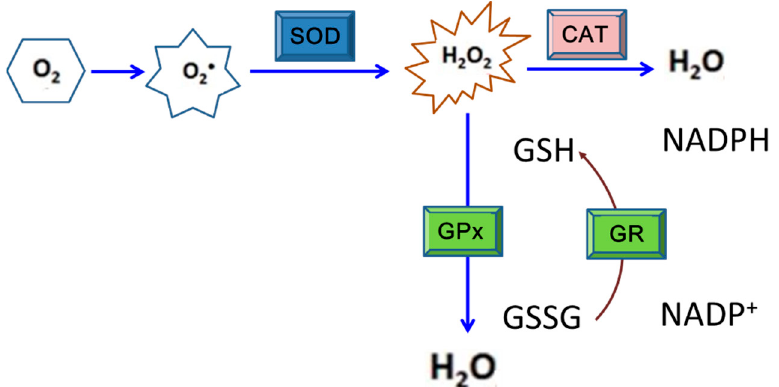
Figure 2. The enzymatic antioxidant system consisting of superoxide dismutase (SOD), catalase (CAT), glutathione peroxidase (GPx), and glutathione reductase (GR) that works for cell protection under oxidative stress. This is the principal defense system against reactive oxygen species (ROS) exposure in most organisms. SOD is able to catalyze the reaction to decompose superoxide anion radicals to H 2 O 2 , which is then converted to water and oxygen by CAT or GPx. Generally, CAT is the most efficient redox enzyme that catalyzes the conversion of H 2 O 2 to water and oxygen. Alternatively, H 2 O 2 can be removed via oxidizing glutathione to become GSSG by GPx; in which GR is also involved.